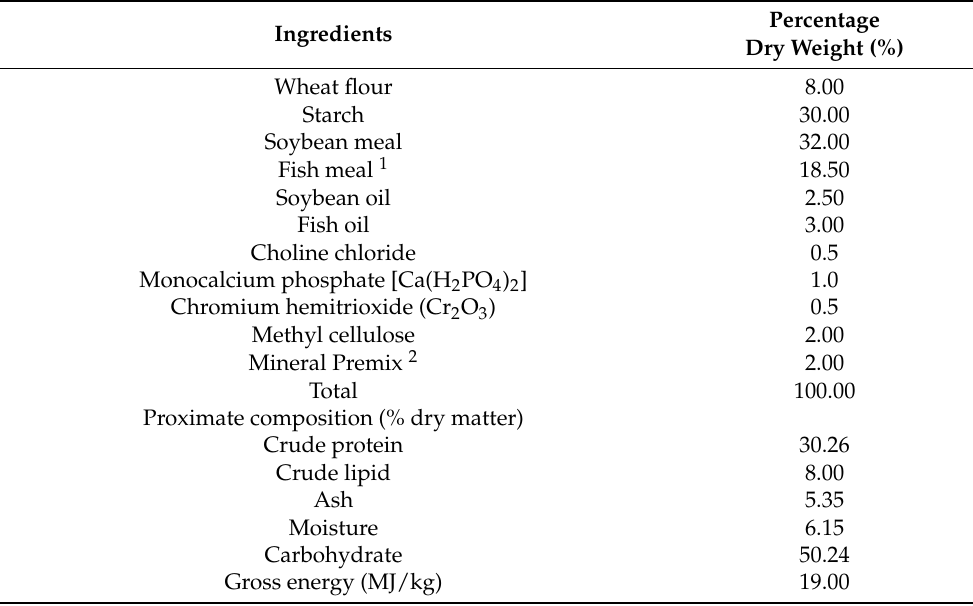
Table 1. Diet formulation and proximate composition of the experimental diet (% in dry